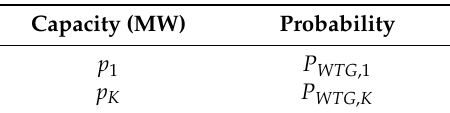
Table 2. Output table of a